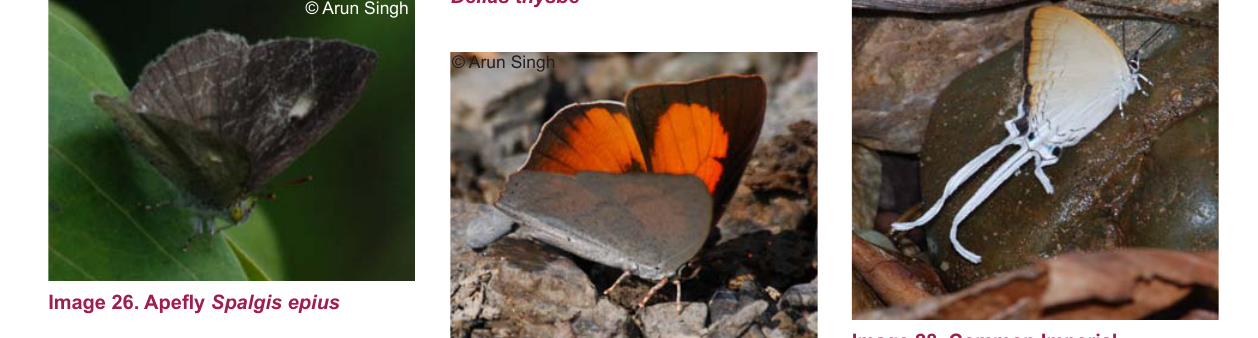
Image 28. Common Imperial Cheritra freja